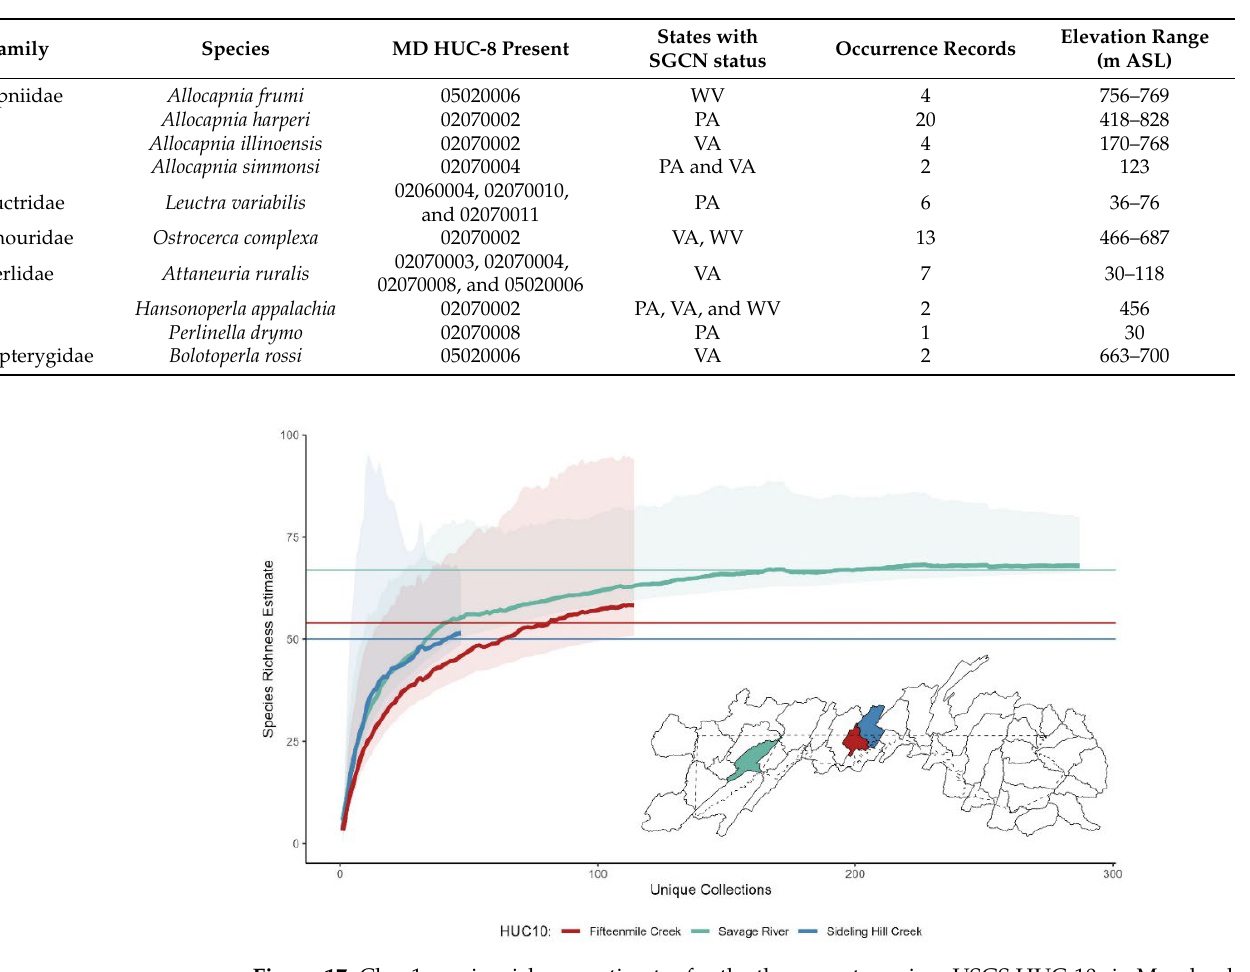
Figure 17. Chao1 species richness estimates for the three most speciose USGS HUC-10s in Maryland. Horizontal lines indicate observed species richness for each USGS HUC-10. For each estimate, 95% confidence intervals are provided. Locations of each selected HUC-10 within the four westernmost counties of Maryland are represented in an inset map.